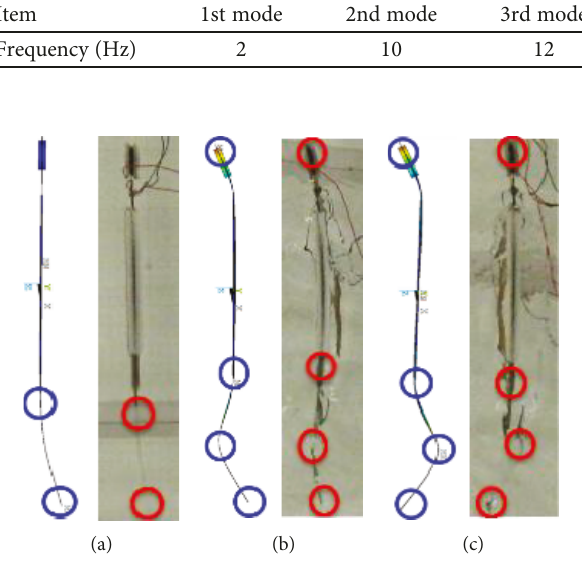
Figure 9: Bending propulsion modes of the new soft robot prototype in simulation and experiment. (a) First bending propulsion modes at 2 Hz. (b) Second bending propulsion modes at 10 Hz. (c) Third bending propulsion modes at 12